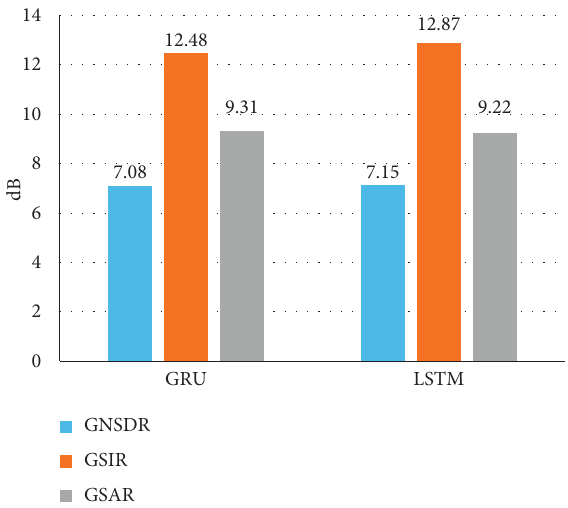
Figure 3: The comparison for the effect of GRU and LSTM in